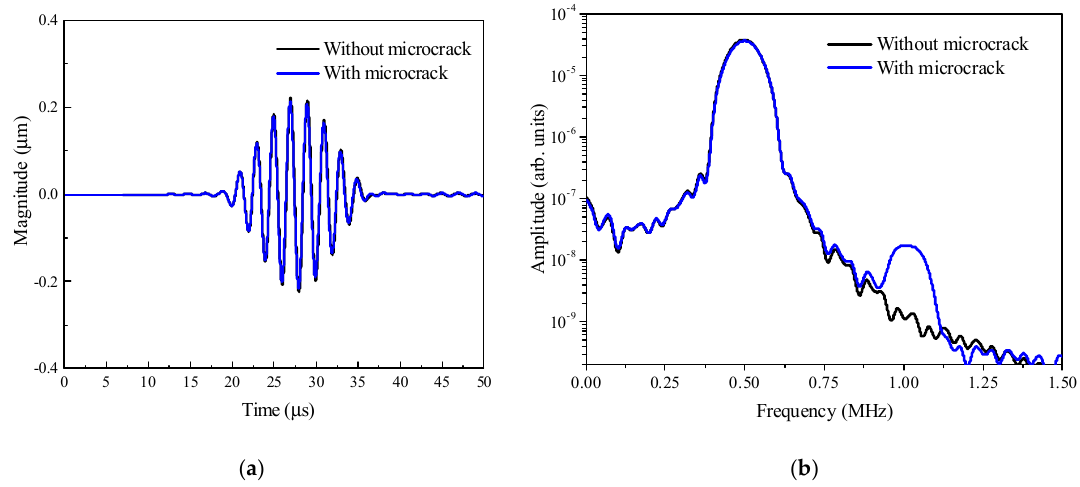
Figure 4. The time-domain signals ( a ) and the corresponding amplitude–frequency curves ( b ) with and without microcrack.